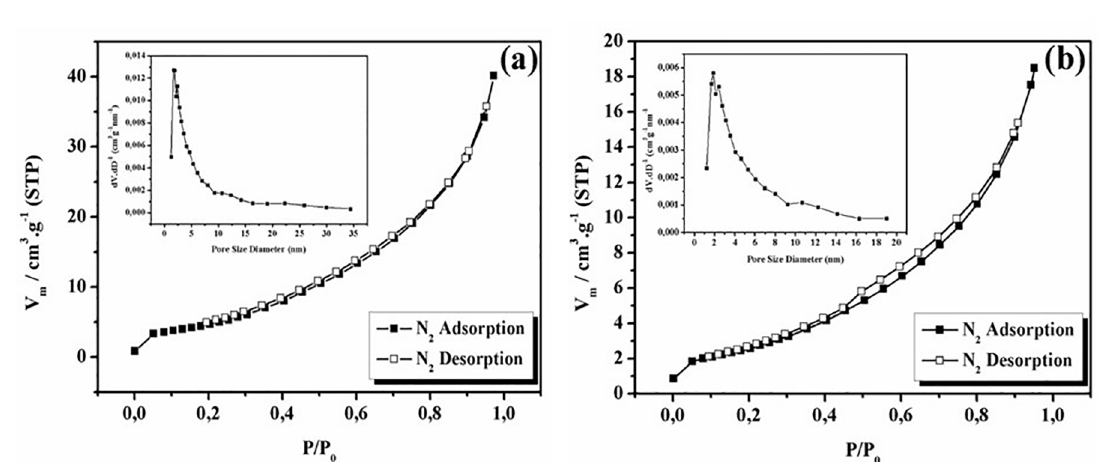
adsorption / desorption isotherms of CuNa05 (a) and CuNH05 (b). Figure 6. N 2